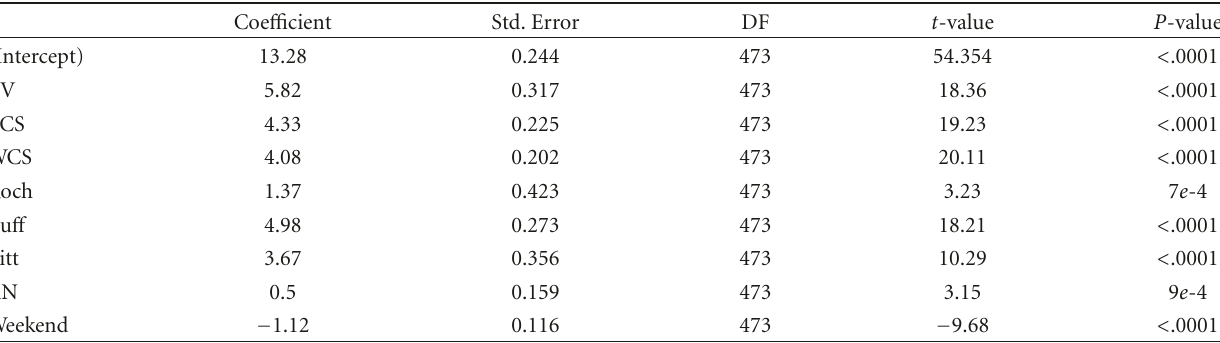
Table 2: Fixed e ff ects.